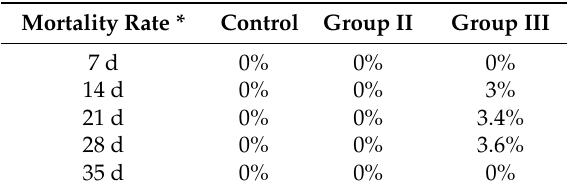
Table 4. The influence of ALV-K infection on